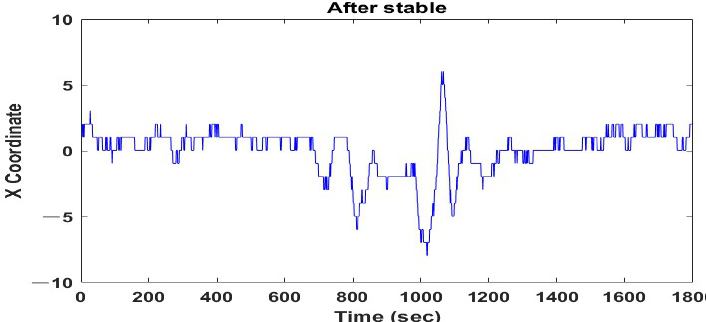
Figure 4. Example of n samples for facial X (or Y)-coordinates.